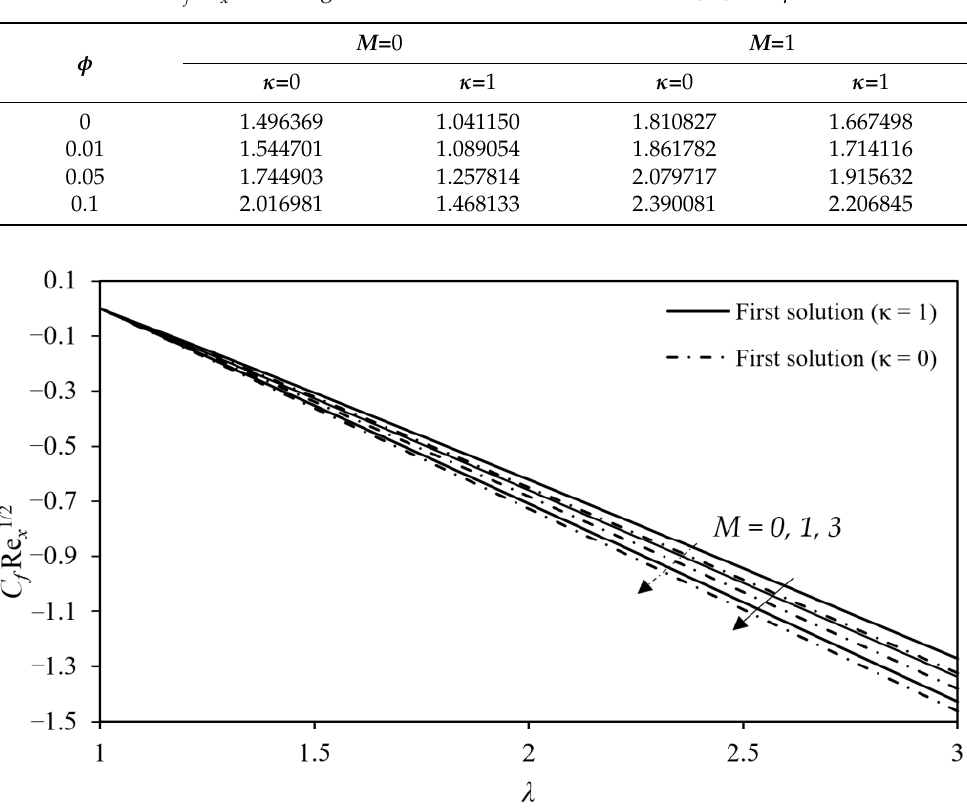
Figure 5. Impact of the magnetic parameter, M , on the velocity profiles for different  and . 